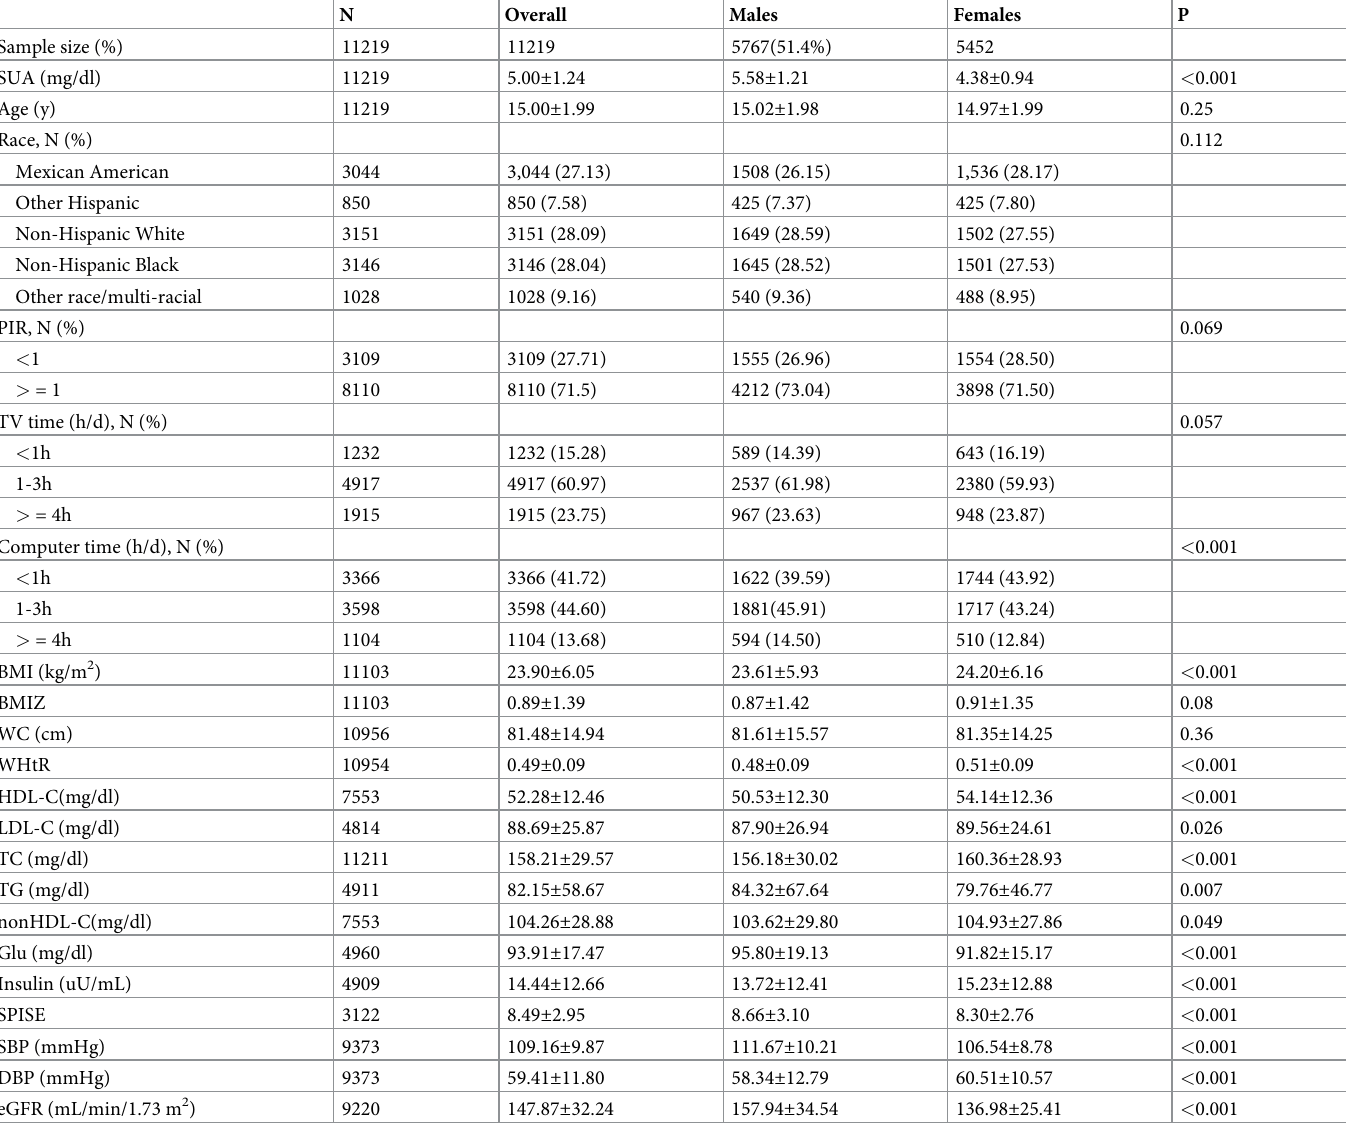
Table 1. Comparison of characteristics of the study population between boys and girls in NHANES 2001–2018. N Overall Males Females